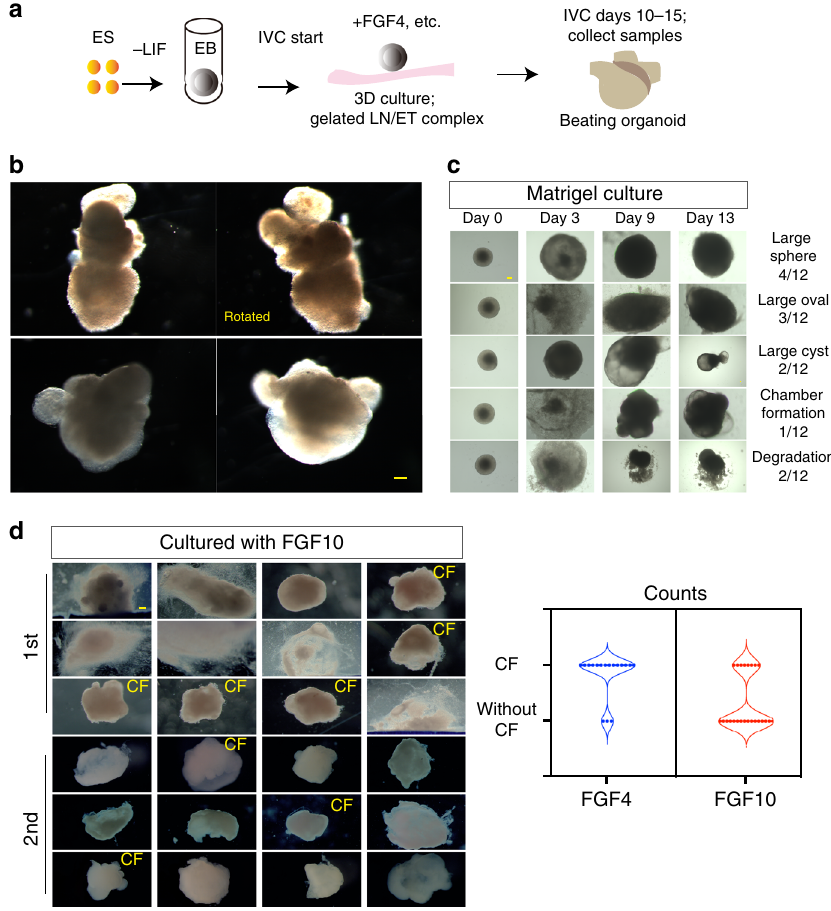
Fig. 1 In vitro generation of developing heart-like structures. a Experimental scheme to generate heart organoid (HO)s in vitro. EBs derived from ESCs were transferred to gelated LN/ET complex-coated chamber slides with HO medium containing FGF4. IVC in vitro culture. b Three representative beating HOs with multiple chambers generated using the above culture system after culturing for 10 − 11 days ( n = over 39, over six experiments). Scale bar: 100 μ m. See also Supplementary Movie 1. c HOs tracking morphological changes over a time course during the culture with Matrigel. HOs were classi fi ed into four types according to their morphology ( n = 12, two experiments). Chamber formation was hindered in the Matrigel culture. Scale bar: 100 μ m. d Effect of FGF10 for HO formation. Twenty-four EBs were cultured with FGF10 instead of FGF4 on LN/ET complex (two experiments). Reduced ef fi ciency (42%, n = 12 for the fi rst experiment, and 25%, n = 12 for the second experiment) of chamber formation compared with the FGF4 condition (88%, n = 8 for the fi rst experiment, and 78%, n = 9 for the second experiment) was shown after culturing for 15 days. Data are presented in a violin plot showing all points. Scale bar: 100 μ